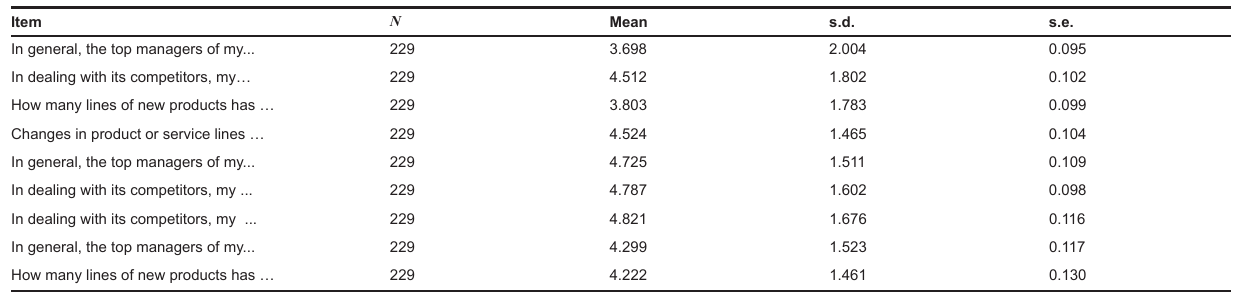
TABLE 5 Descriptive statistics of entrepreneurial orientation